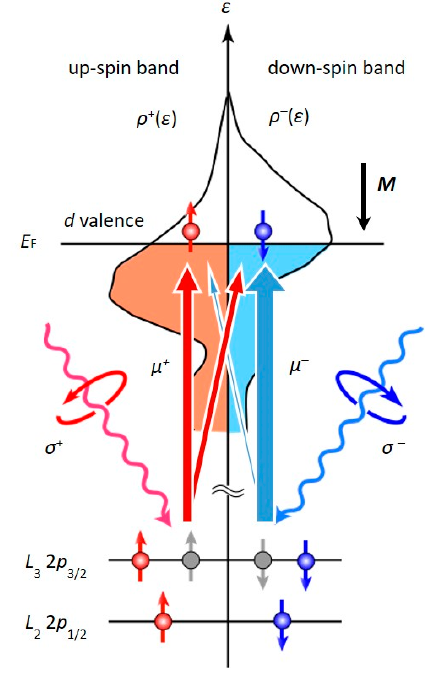
Figure 7. Diagram of the electronic states related to X-ray absorption spectroscopy and X-ray magnetic circular dichroism (XAS / XMCD) measurements at the L -edges of transition metals.